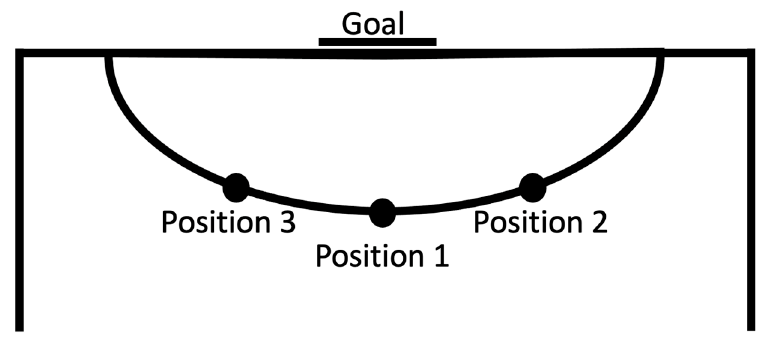
Figure 1. Participant positions for goal-shooting.